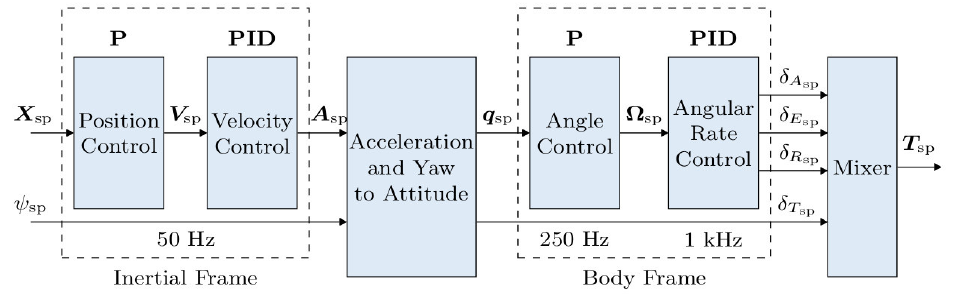
Figure 10. PX4 offboard multi ‐ copter controller diagram